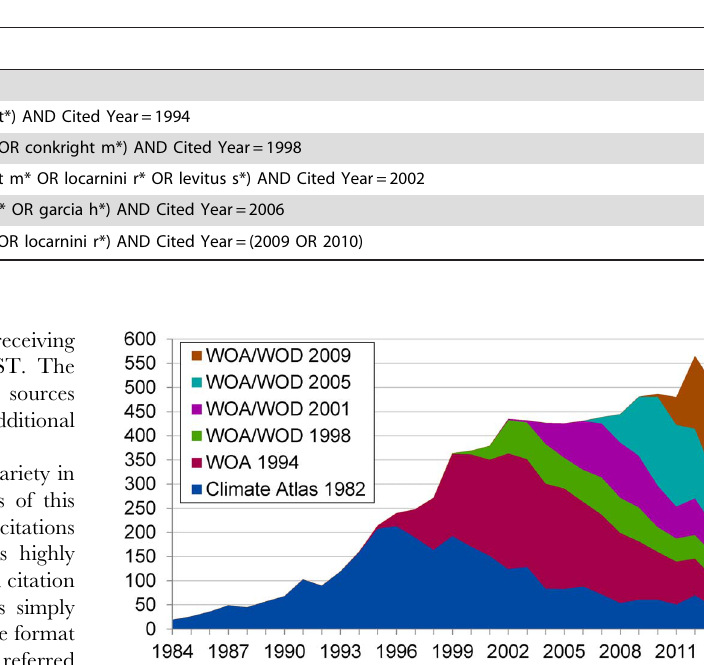
Figure 2. Number of citations received per year by all editions of the